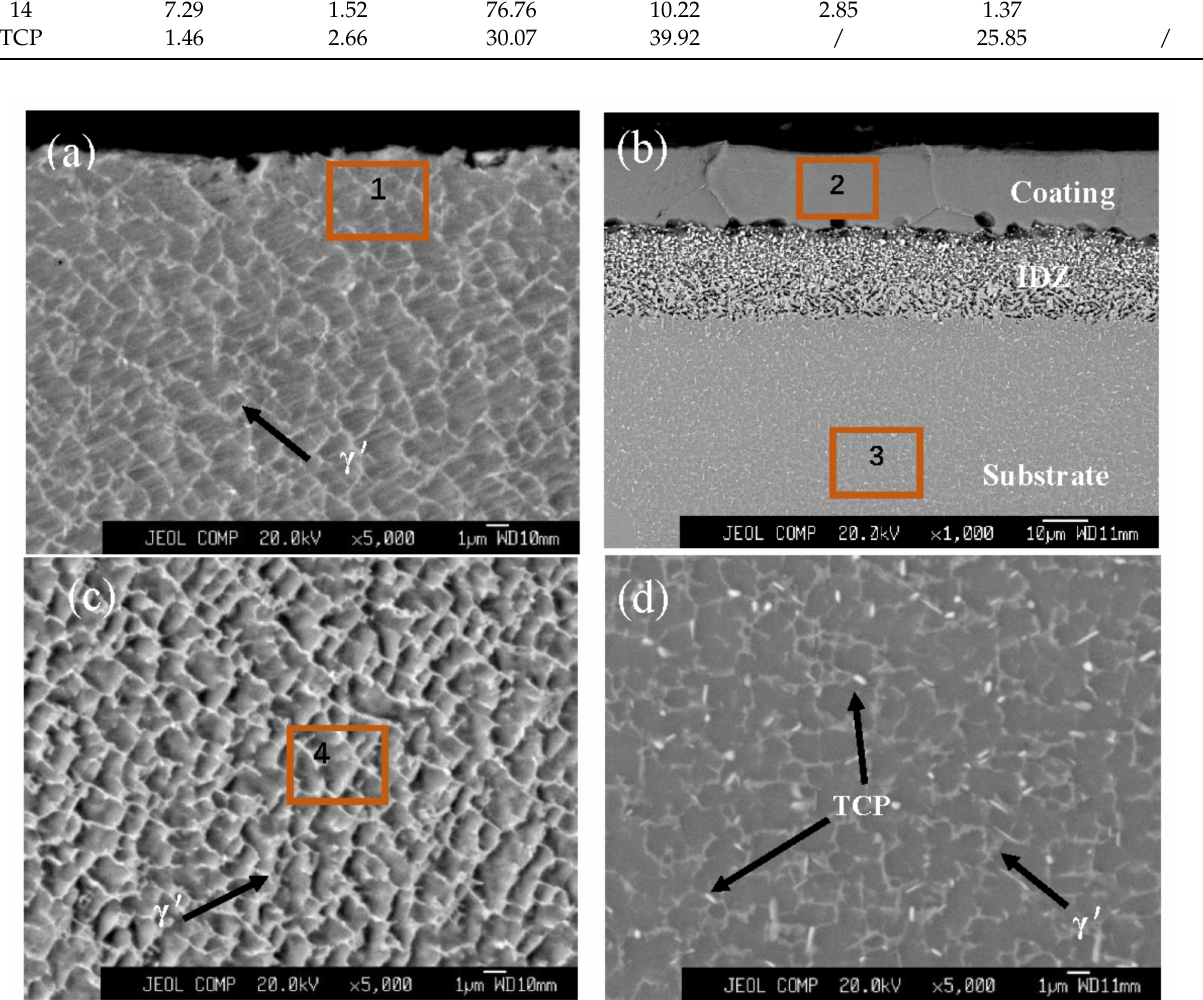
Figure 1. The backscattered electron image of the cross-section of ( a , c ) IC21 substrate, and ( b , d ) with coating before thermal